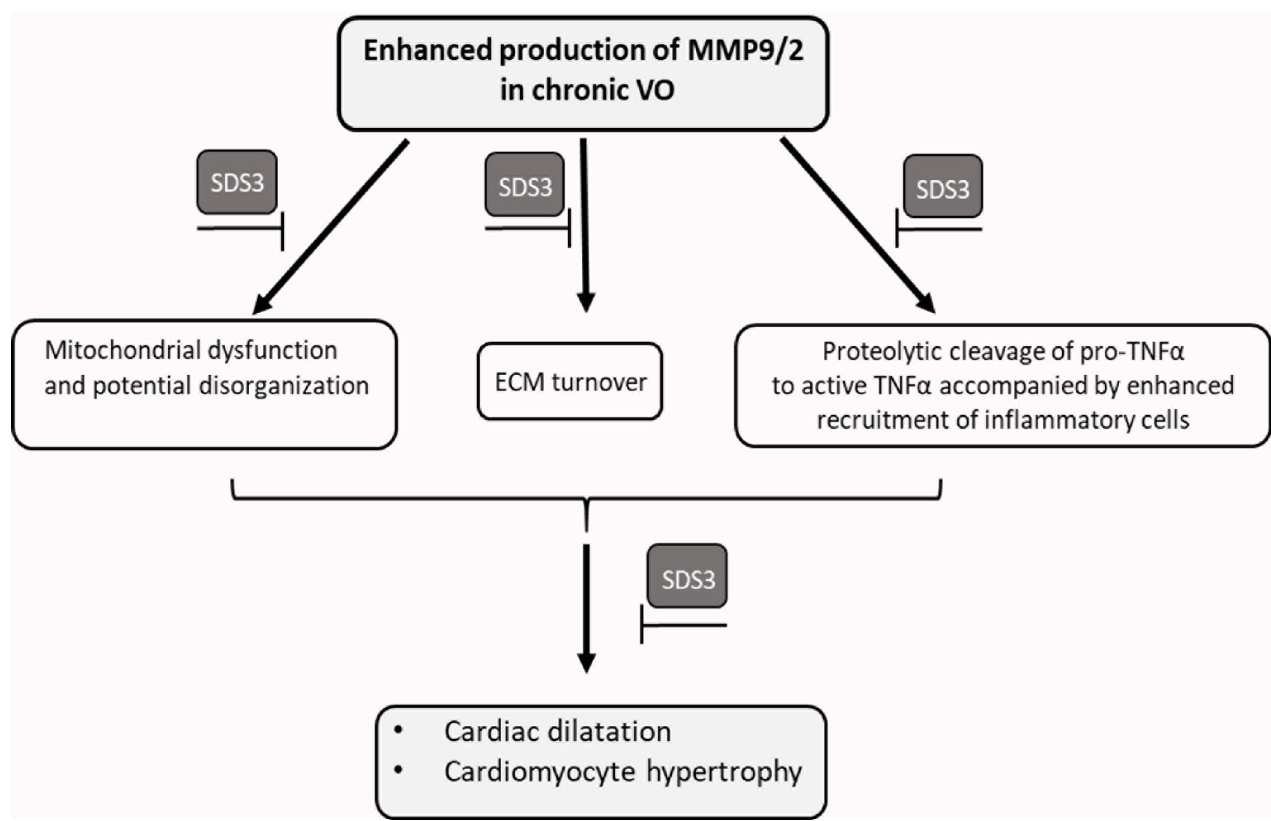
S1 Fig. (A) Left panel: representative pictures illustrating LV myocyte cross-sections stained with WGA. Right panel: cross-sectional area (CSA) quantification (n = 3-4/group). Scale bar— 100 μ m (B) Left panel: Representative Masson’s trichrome-stained histological sections; Right panel: Percentage of fibrosis quantification (n = 5/per group). (C) Left panel: Representative immunofluorescent images of CD45 expression (green) in LV sections. Dapi staining of nuclei is represented in blue. Right panel: Mean total number of white blood cells per field. Scale bar -25 μ m. (TIF) S1 Data. Primer sequences used for RT-PCR.